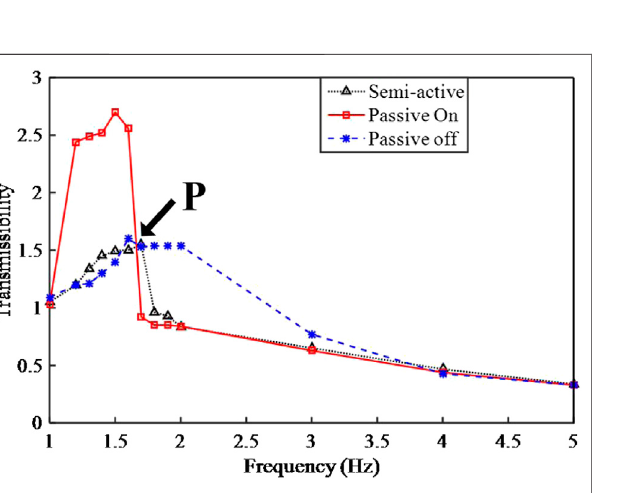
FIGURE 13 | Experimental setup for evaluating the vibration isolation performance (CompactRIO: Crio-9074, mit 400 MHz CPU, 128 MB DRAM, 256 MB Speicher, FPGA mit 2 Millionen Gattern, eight Slots).